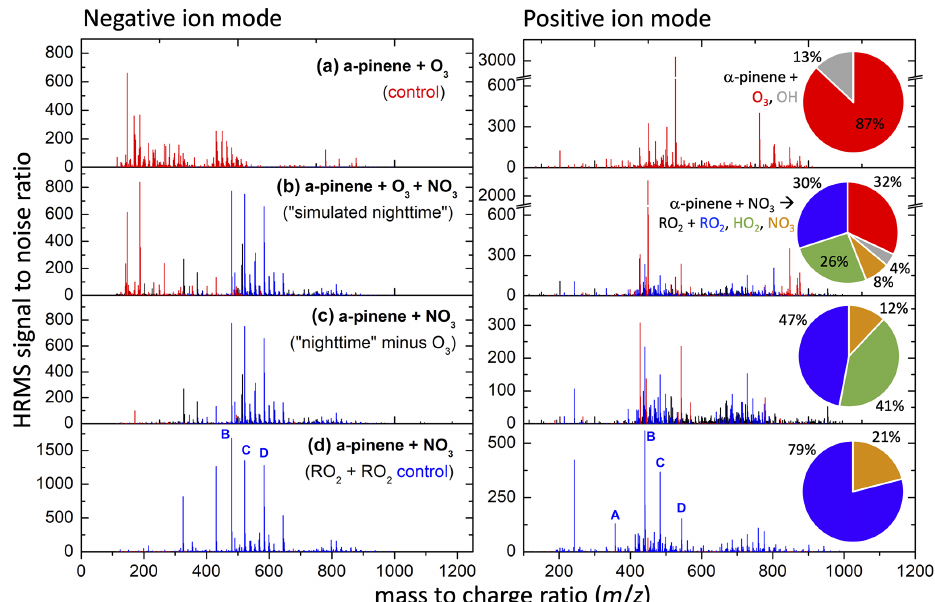
Figure 8. Mass spectra of filter samples from experiments 26 (d) and 27 (b) , along with the ozonolysis-only control for experiment 27 (a) and the signal difference (c) between (b) and (a) . Peaks uniquely attributable to α -pinene ozonolysis alone are shown in red, while those uniquely attributable to α -pinene + NO 3 followed by RO 2 + RO 2 chemistry are shown in blue, with all other peaks in black. Pie charts denote the fraction of α -pinene reacting via each pathway for a given experiment. Key dimer species (A–D) identified in the bottom panels and their peroxy radical precursors are shown in Figs. 9–10.